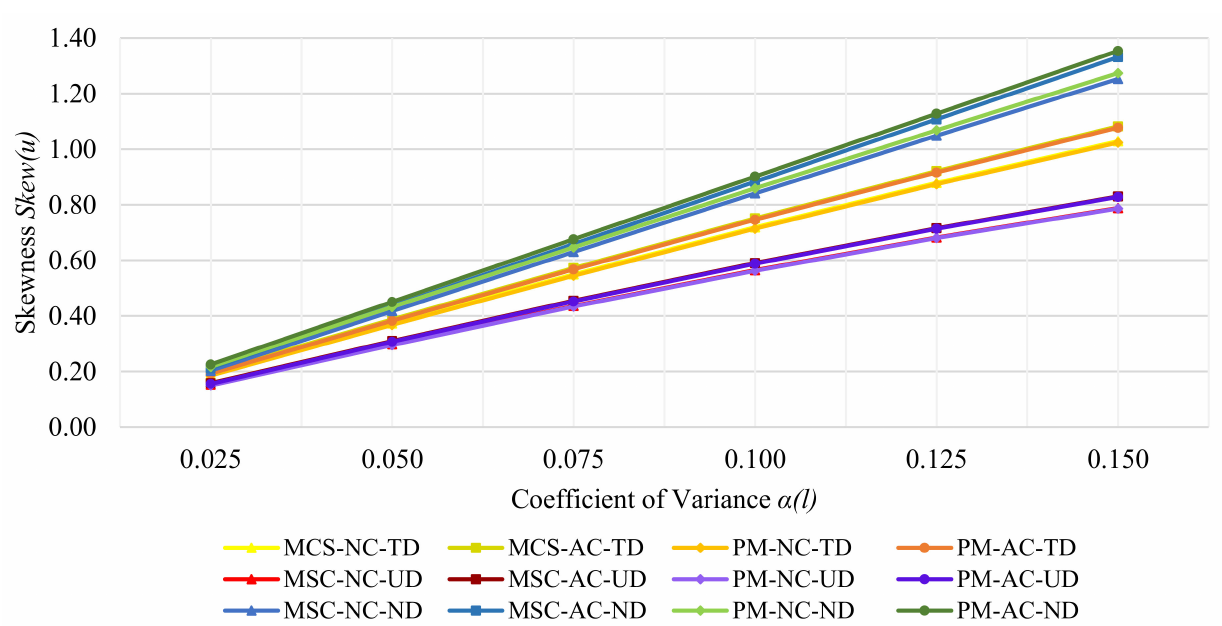
Figure 8. Skewness Skew ( u ) in the